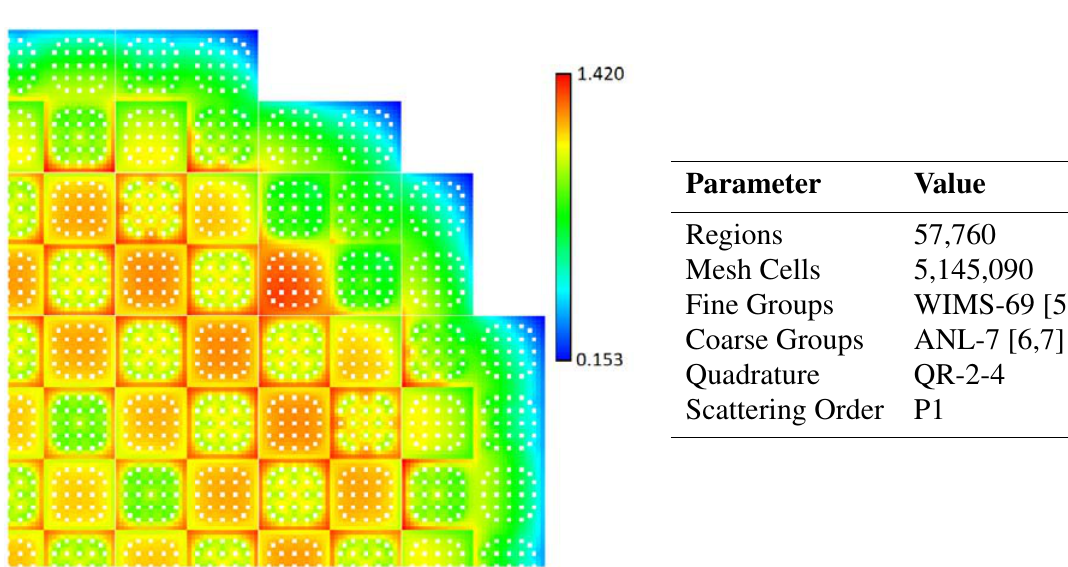
Figure 1: Relative pin fission density distribution and parameters for the test